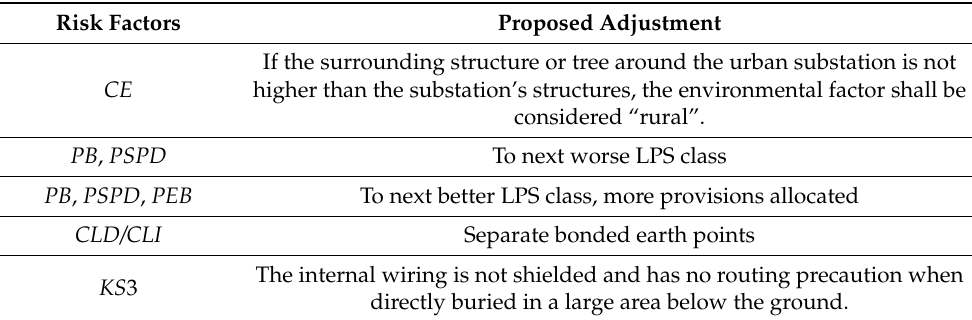
Table 20. Proposed Adjustment Risk Factors-Worse-case.